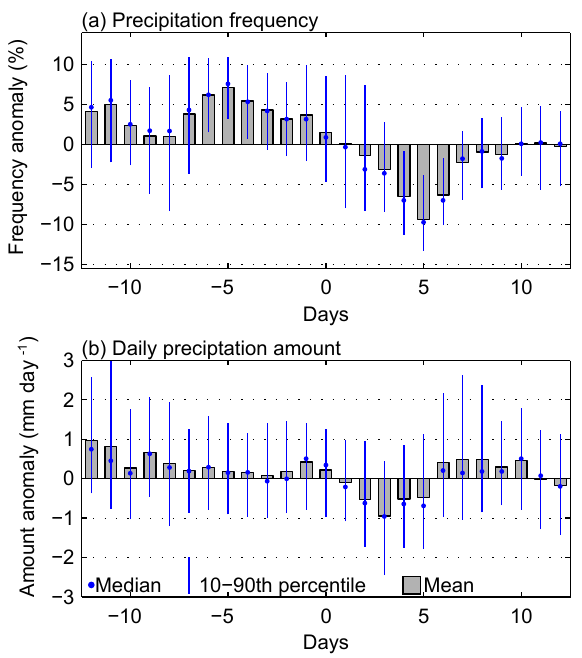
Figure 2. The anomalies of precipitation frequency (a) and amount (b) computed based on 155 stations. The means are shown as gray bars; and the median and the range of the 10th–90th per- centiles are also plotted for